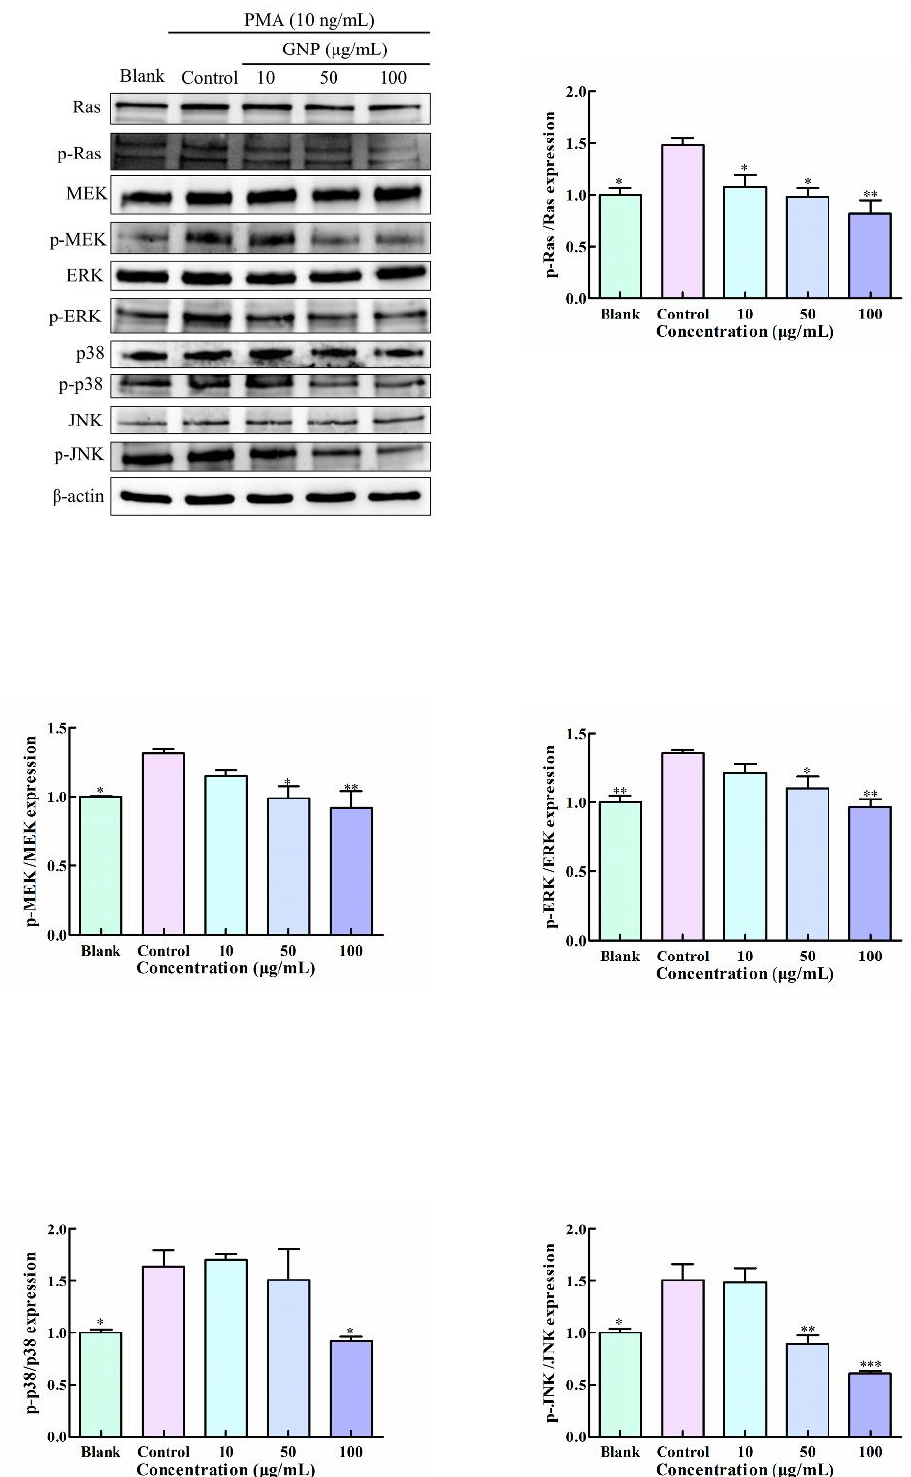
Figure 6. The protein level of MAPK signaling pathway in HT1080 cells was determined by western blot analysis. β -actin was used as an internal control. Data are shown as mean ± SD ( n = 3). p < 0.05 (*), p < 0.01 (**), p < 0.001 (***) compared with PMA alone treated control group.